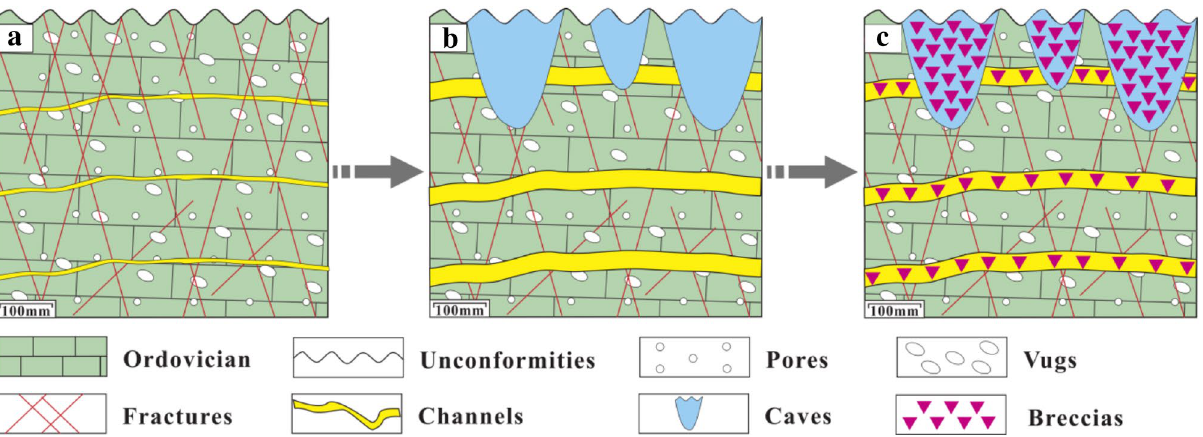
Figure 14. Development model of caves and channels in the Ordovician paleoweathering crust: ( a ) A porous geological body formation; ( b ) Large dissolution channels and caves formation; ( c ) Collapse breccias filled the channels and